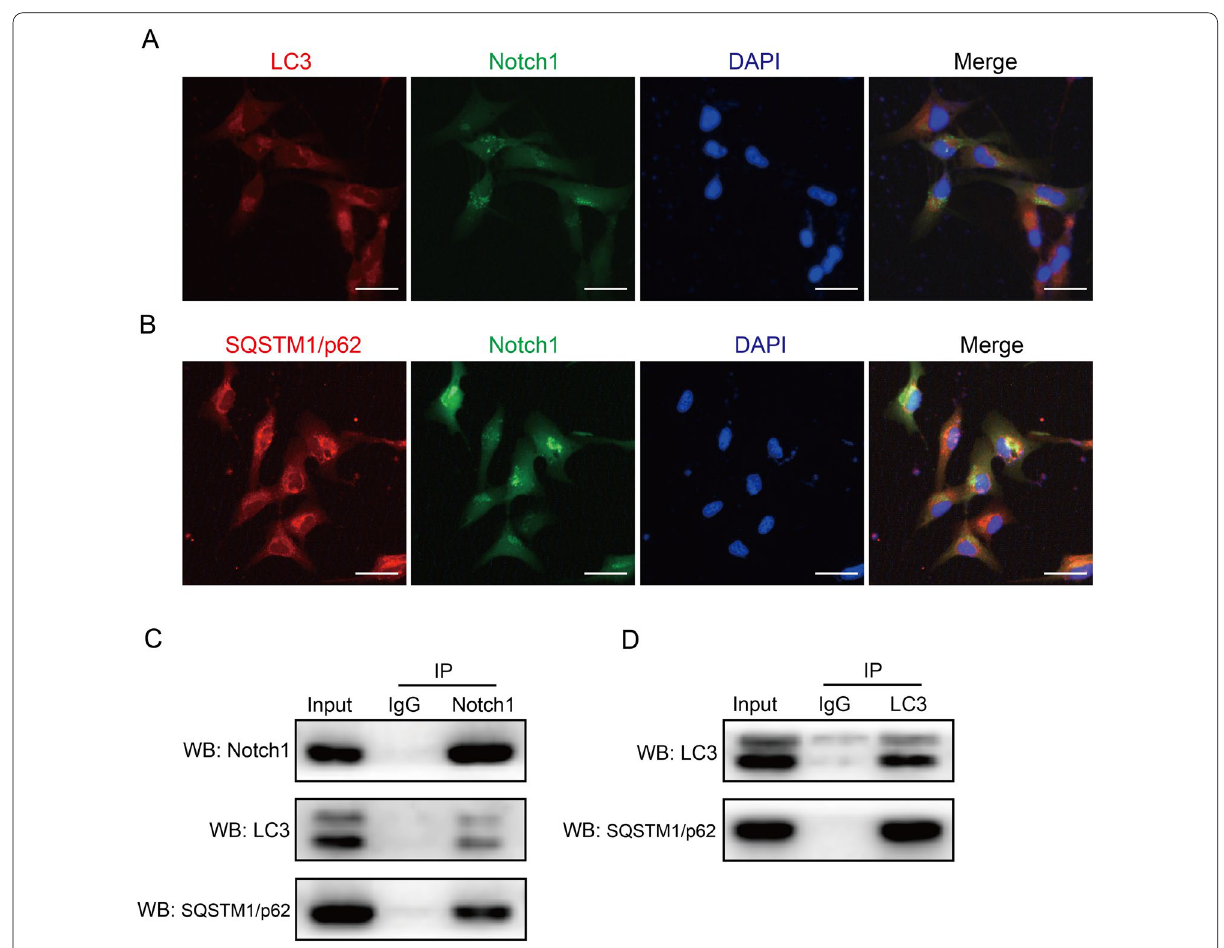
Fig. 5 Autophagy promoted Notch1 degradation through the interactions of Notch1, LC3 and SQSTM1/p62. HLE-B3 cells were cultured in DMEM (5.5 mM glucose) for 24 h. A Immunofluorescence staining for LC3 (red) and Notch1 (green) in HLE-B3 cells, bar 40 μm. B = Immunofluorescence staining for SQSTM1/p62 (red) and Notch1 (green) in HLE-B3 cells, bar 40 μm. C , D Co-IP of Notch1, LC3 and SQSTM1/p62. = IP: immunoprecipitation, WB: Western blot, n 3 =